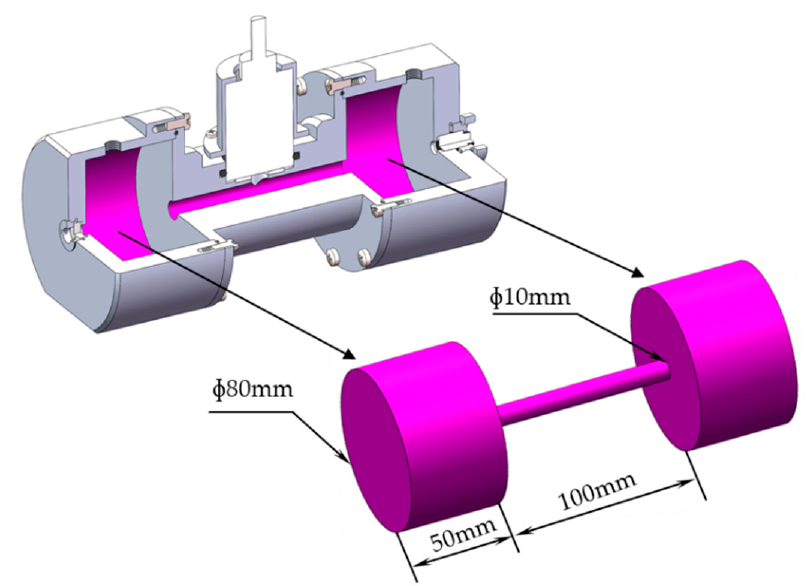
Figure 4. The structure of the photoacoustic cell.